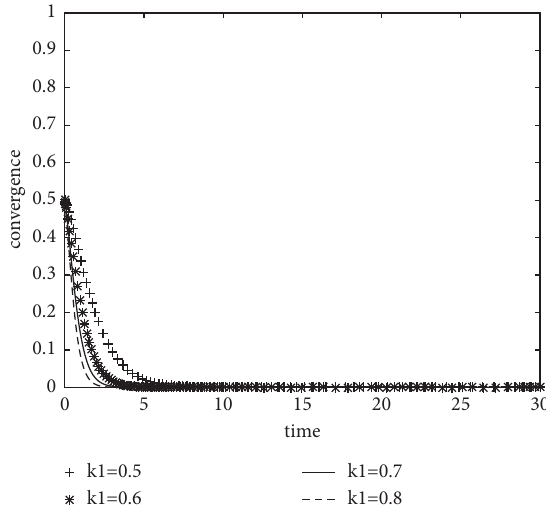
Figure 8: Impact of changing K